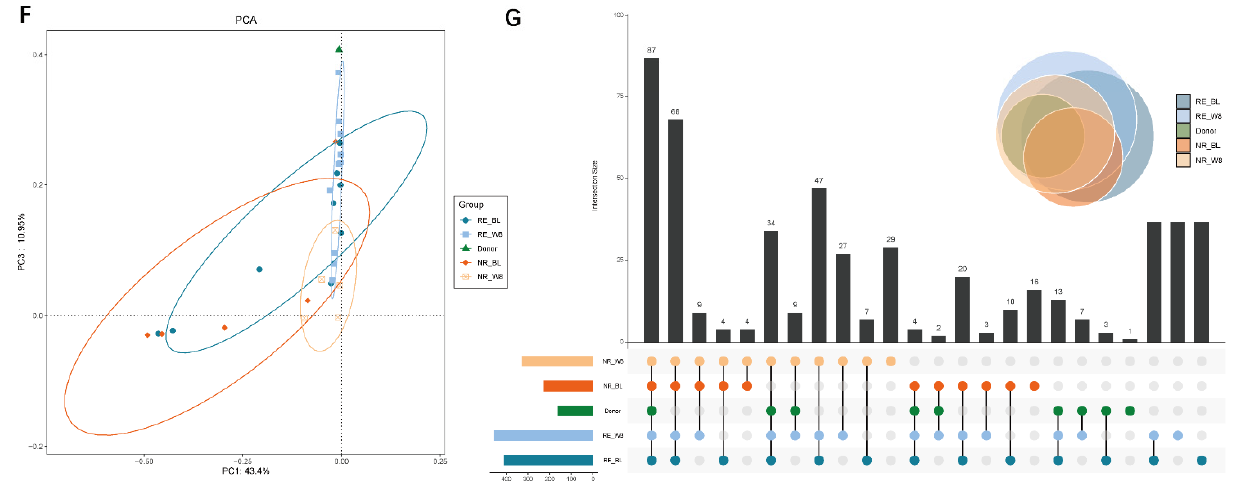
Figure 3. Changes in intestinal microbiota diversity in responders (RE) and non-responders (NR) groups at baseline (BL) and week 8 (W8). ( A , B ) α -diversity reflected by chao index. ( C , D ) α -diversity reflected by observed community operational taxonomic units (OUTs). ( E ) OUTs at multi-time points. ( F ) β -diversity reflected by principal component analysis (PCA). ( G ) Venn diagram showing the number of unique and common OUTs in donor and FMT groups. (* p < 0.05)